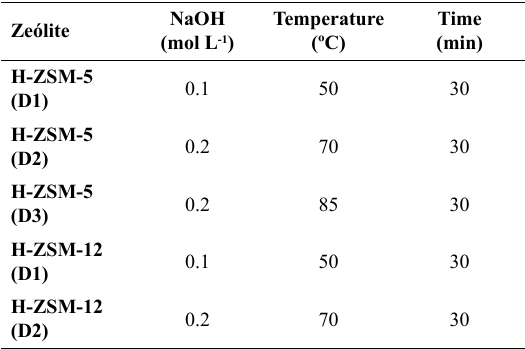
Table 1. Conditions used in